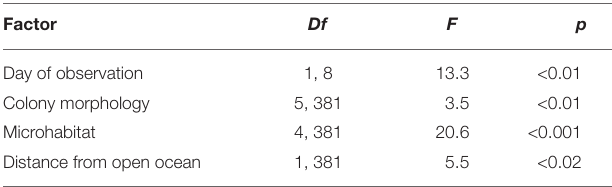
Factor Df F p Day of observation 1, 8 13.3 <0.01 5, 381 3.5 <0.01 Microhabitat 4, 381 20.6 <0.001 1, 381